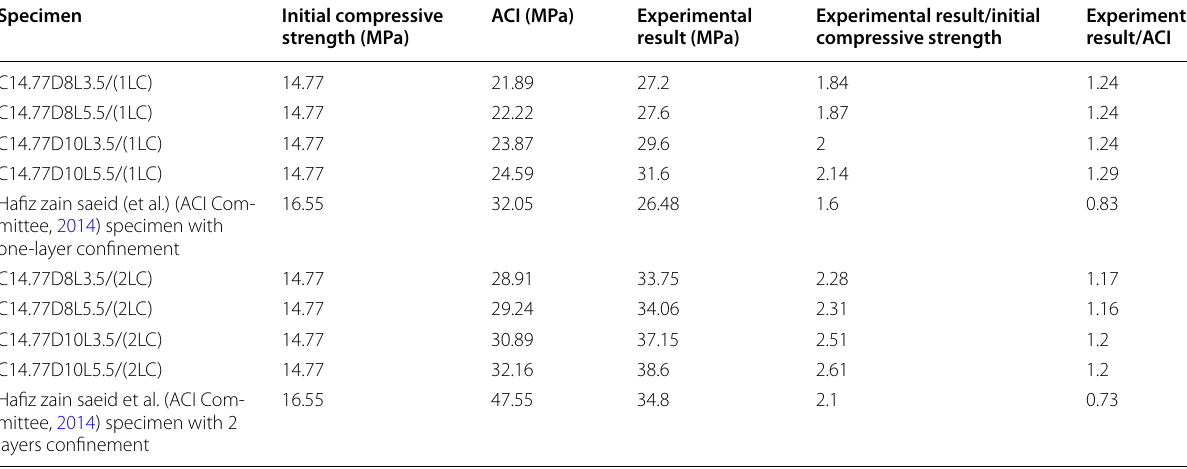
Table 14 Comparison between test results and Hafiz Zain Saeid et al. (Pham et al., 2015) study according to ACI relationships.